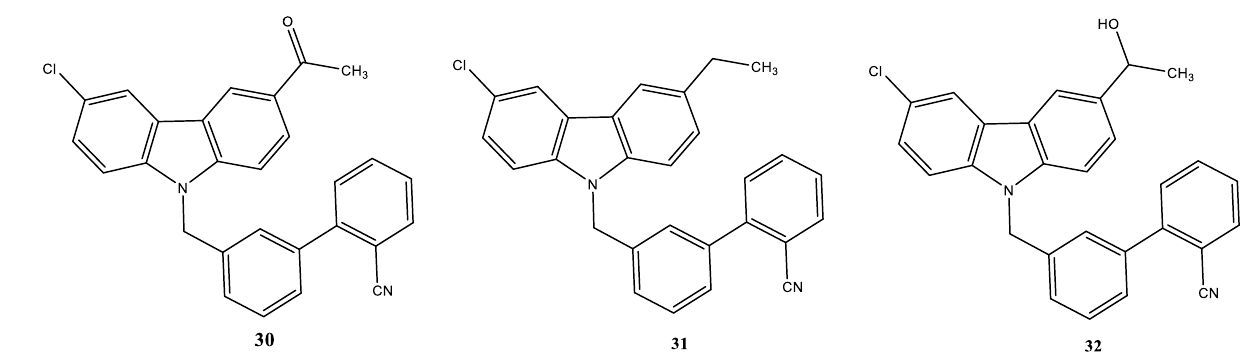
Figure 14. Carbazol-carbonitrile derivatives ( 30-32 ).